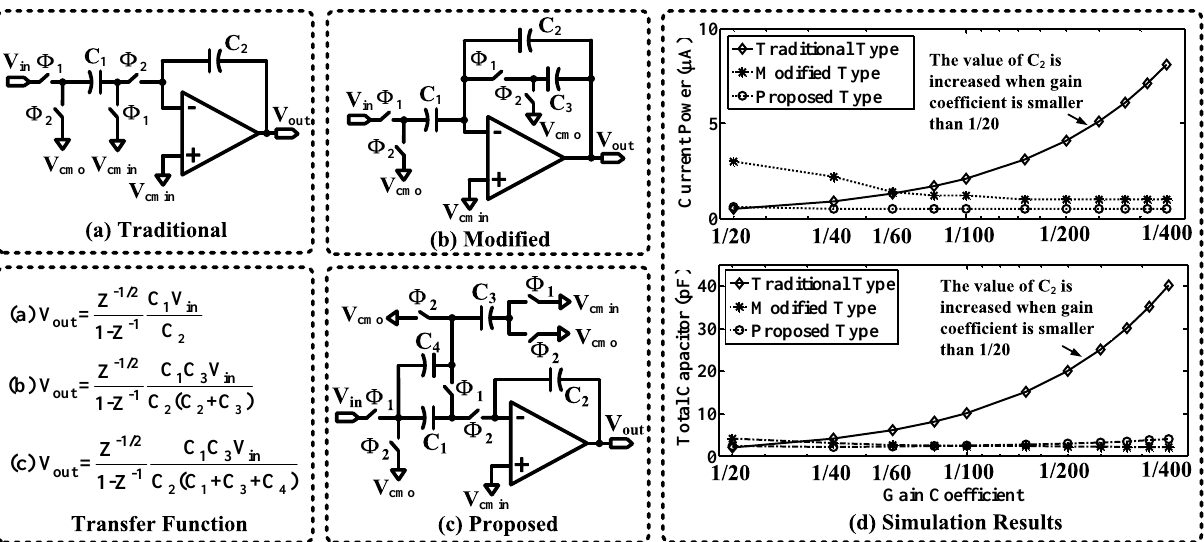
Figure 13. The circuit schematics and simulation results of three resonator structures (( a ) traditional, ( b ) modified and ( c ) proposed). ( d ) Simulated power and area performance of the